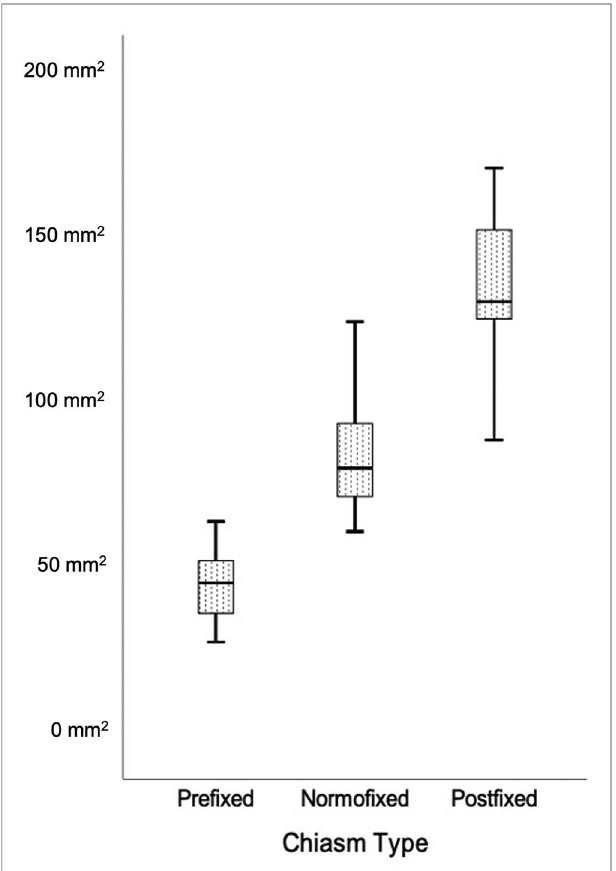
FIGURE 8 | Comparison of the prechiasmatic space in pre fi xed, normo fi xed, and post fi xed optic chiasm